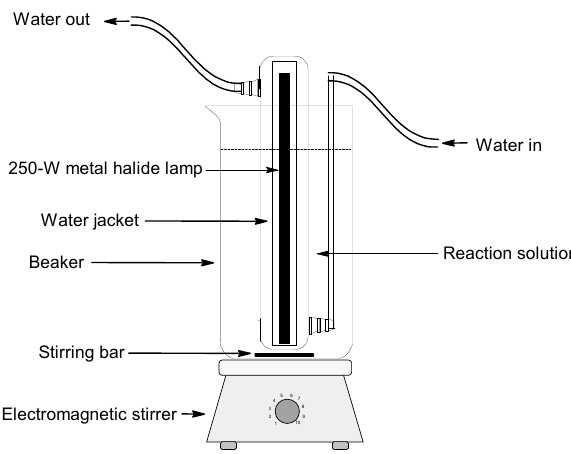
Figure 1. The scheme of the photoreactor used in this study.